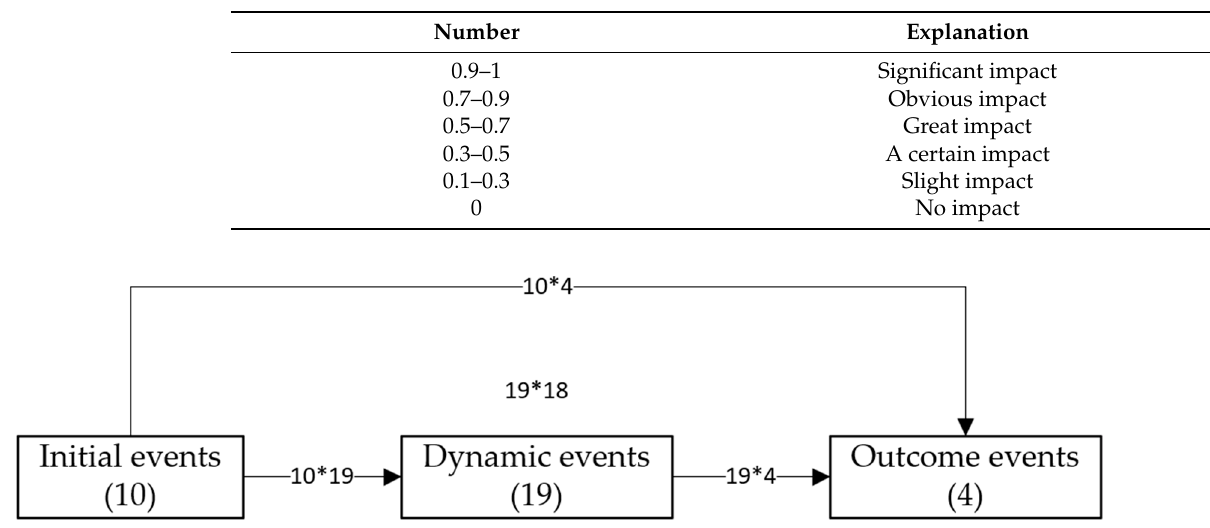
Figure 3. Influence diagram with the number of events and the number of estimates